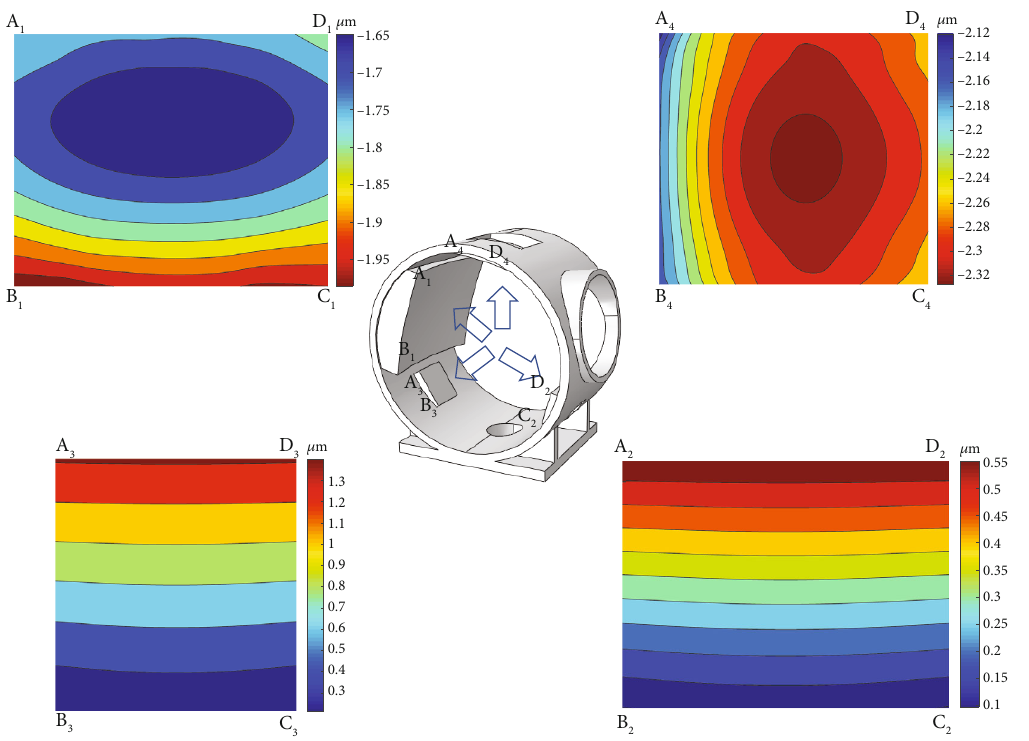
Figure 13: Deformation cloud diagram of di ff erent